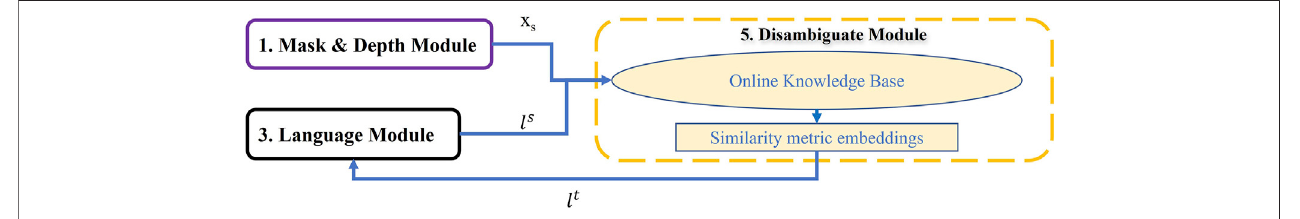
FIGURE 10 | Disambiguate Module: This module searches for images of unclear object labels and try to assign recognized labels to the objects to reduce